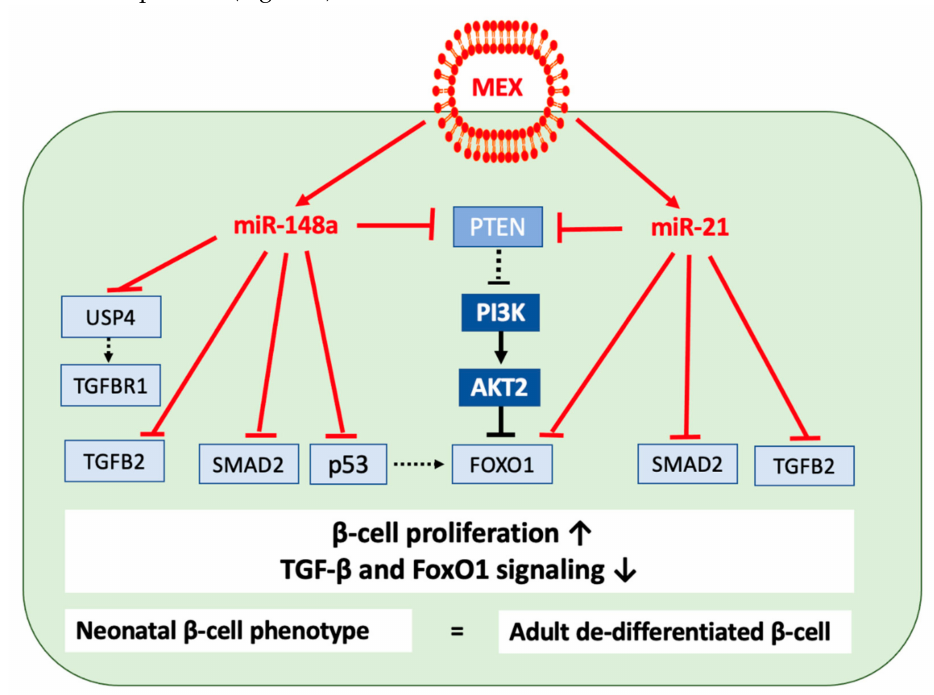
Figure 8. Illustration of the involvement of MEX miRs on β cell transforming growth factor β (TGF- β ) and forkhead box O1 (FOXO1) signaling. MEX miR-148a and miR-21 attenuate TGF- β